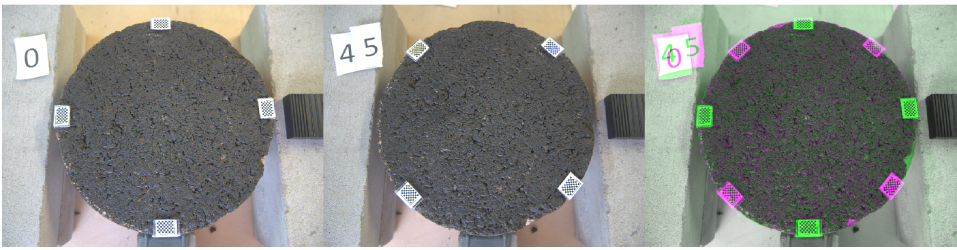
Figure 8. Triplet image. Left: 0th position. Centre: 45th position. Right: Overlapped before transformation.